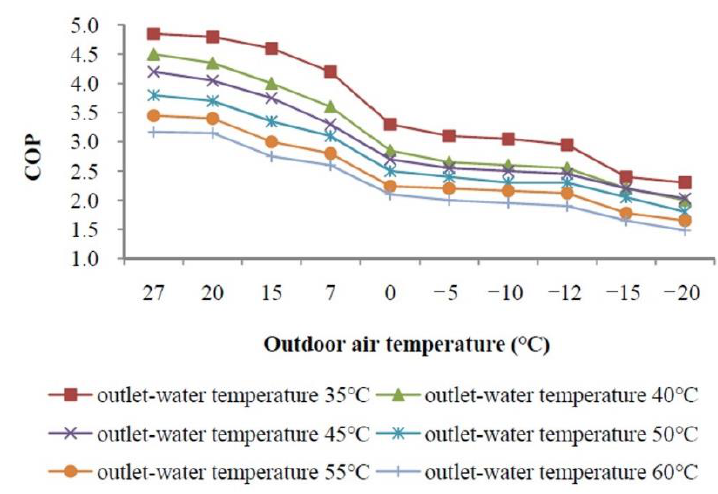
Figure 6. Performance curve of the air source heat pump.